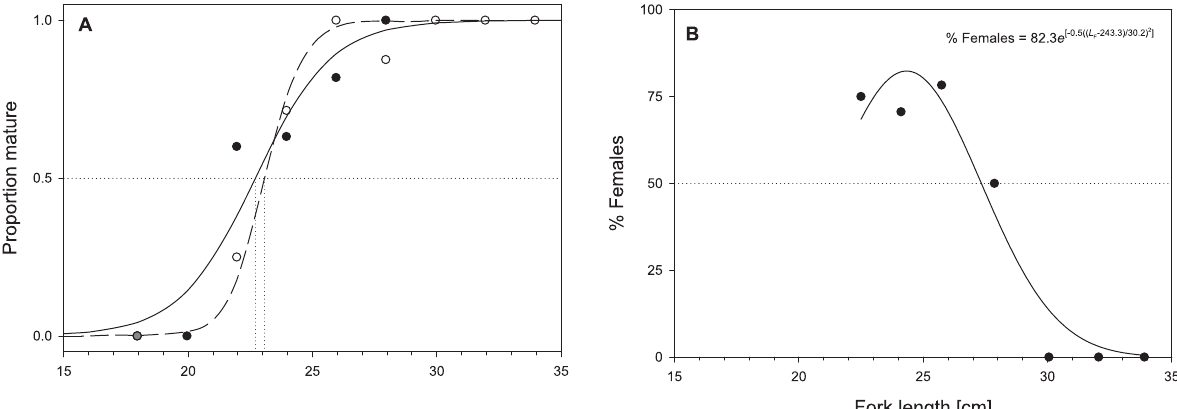
Figure 3. Reproductive information for Lutjanus gibbus from Fiji. ( A ) size at maturity ( L ative to all mature individuals, versus length. Females are represented by closed circles and the solid curves, males are represented by open circles and the dashed